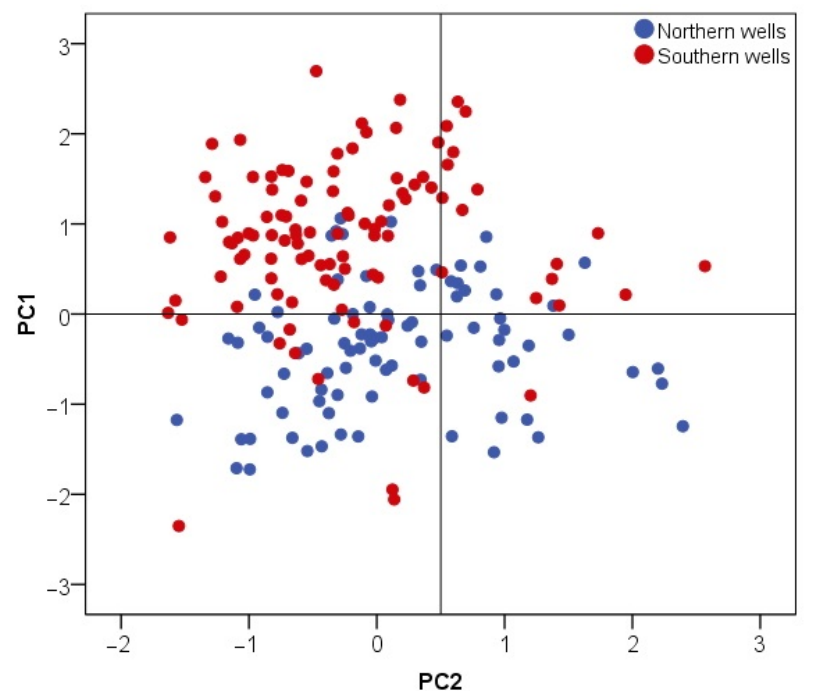
Figure 9. Bivariate plot of the scores of PCs 1 and 2 according to zone of location of the monitoring wells before sewerage.